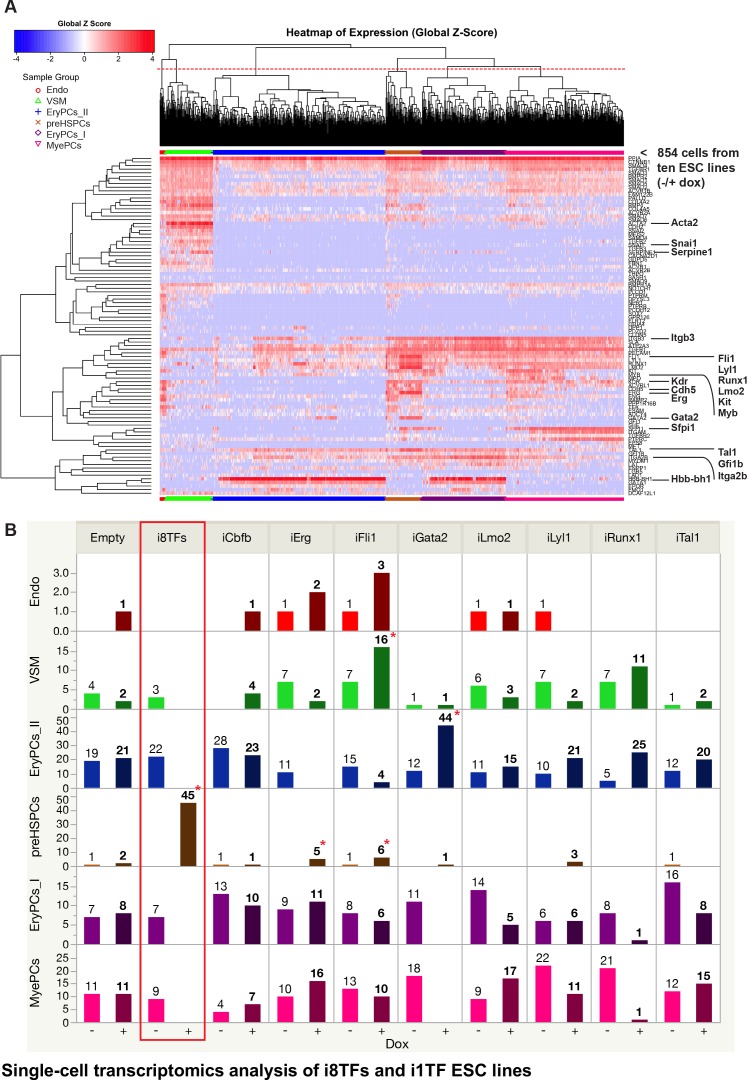
Single-cell transcriptomics analysis of i8TFs and i1TF ESC lines.(A) Hierarchical clustering showing the sc-q-RT-PCR results for 95 genes on the ten inducible ESC lines after three days of BL-CFC culture. The clusters were defined according to the intersection of the red dotted line with the dendrogram in the upper part of the heatmap. (B) Bar graphs displaying the cell number in each of the six clusters defined in (A) for the ten cell lines. Stars indicate significant differences for +dox conditions (see Supplementary file 6 for p-values). See also Figure 4—figure supplements 1 and 2, Supplementary file 1, 6 and 11.